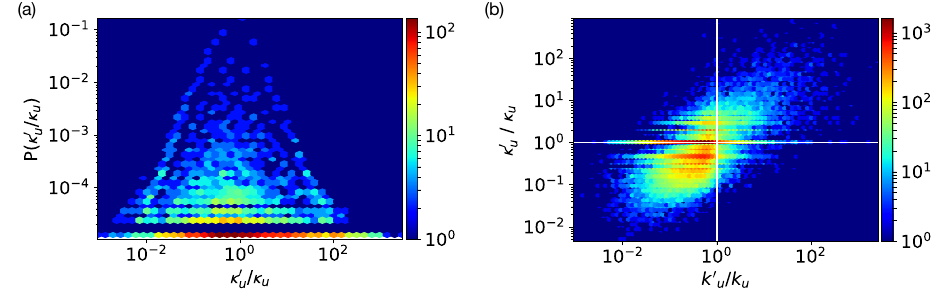
Figure 3. Distributions of roles. ( a ) The P ( κ (cid:48) u / κ u ) distribution of retweet balance across all users shown as a density plot. ( b ) Configuration of the retweet balance (y-axis) in regard to the follower balance (x-axis), i.e., actual vs. potential attention flows measured as the correlation between the ratio of in- and out-degrees in the retweet and follower networks respectively. Heat-map colors code absolute